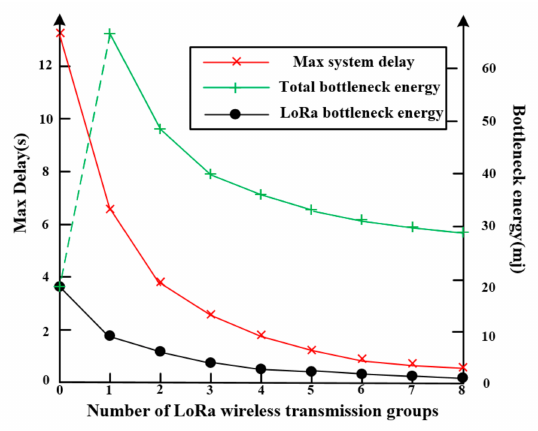
Figure 7. Relationship between the maximum delay and bottleneck energy